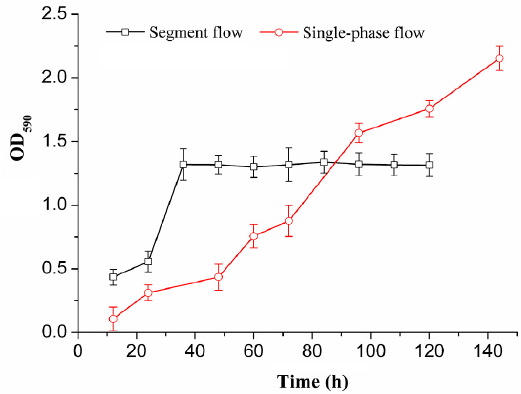
Figure 1. Growth of recombinant E. coli BL21-pET28a- egfp biofilms in a microchannel reactor under different flow modes.